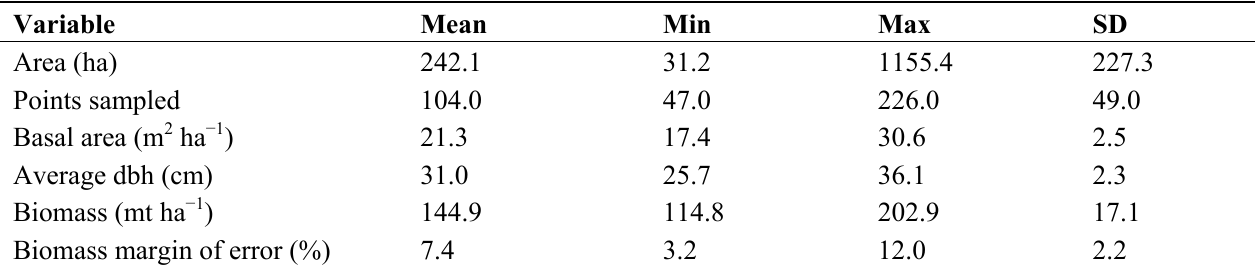
Table 1. Descriptive statistics for original systematic point sample inventories of the 40 properties used in double sample